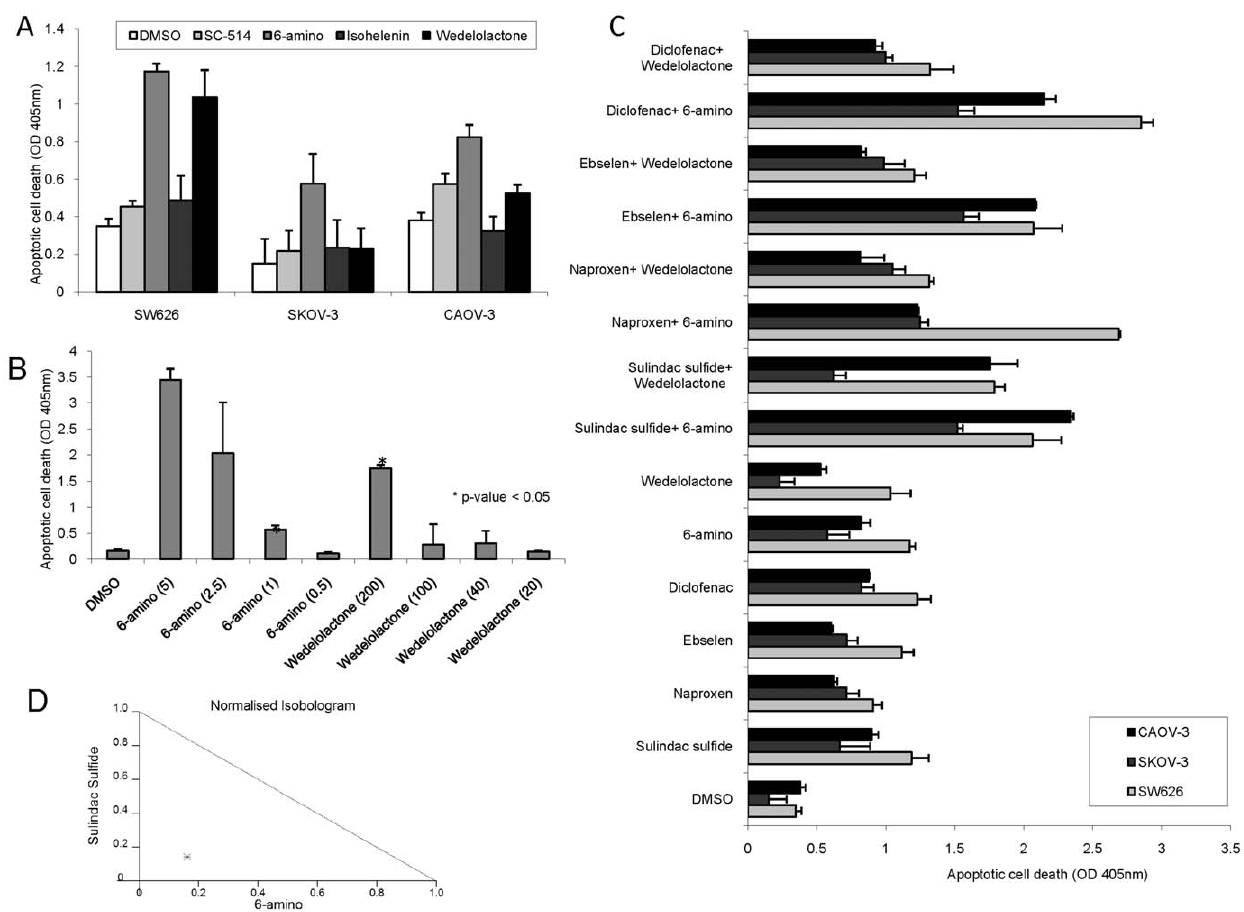
Figure 5. Combinatorial treatment of ovarian cancer cells with NSAIDs and NF- k B inhibitors. (A) Pharmacological NF- k B inhibitors induce apoptosis in ovarian cancer cells. SW626, CAOV-3, and SKOV-3 cells after treatment with 5 nM 6-Amino-4-(4-phenoxyphenylethylamino) quinazoline (6-amino), 50 m M Isohelenin, 50 m M IKK-2 inhibitor SC-514, and 200 m M IKK inhibitor II Wedelolactone (7-Methoxy-5,11,12-trihydroxy-coumestan) or DMSO as control. Data means 6 s.d. of triplicate independent experiments for each treatment. (B) Dose-dependent induction of apoptosis by NF- k B inhibitors in ovarian cancer cells. Apoptosis assay of SKOV-3 ovarian cancer cells. Cells were treated with 5, 2.5, 1 and 0.5 nM of 6-Amino-4-(4- phenoxyphenylethylamino) quinazoline (6-amino) 50, 25, 10 and 5 m M of Isohelenin, 50, 25, 10 and 5 m M of IKK inhibitor II Wedelolactone (7- Methoxy-5,11,12-trihydroxy-coumestan) (Wedelolactone), 50, 25, 10 and 5 m M of IKK-2 inhibitor SC-514 or DMSO. Apoptosis was measured 24 hours post-treatment. Data means 6 s.d. of triplicate independent experiments for each treatment. (C) Apoptosis in ovarian cancer cells after NSAID treatment in combination with NF- k B inhibitors. SW626, CAOV-3, and SKOV-3 cells after treatment with 10 m M Sulindac Sulfide, 40 m M Diclofenac, 25 m M Ebselen, 40 m M Naproxen, 1 nM 6-Amino-4-(4 phenoxyphenylethylamino) quinazoline (6-amino), and 200 m M IKK inhibitor II Wedelolactone and a combination thereof. Apoptosis was measured 24 hours after treatment. Data means 6 s.d. of triplicate independent experiments for each treatment. (D) Normalised isobologram obtained by software Compusyn. CAOV-3 cells treated with a combination of 10 m M Sulindac Sulfide and 2.5 nM 6-amino shows synergistic effect.